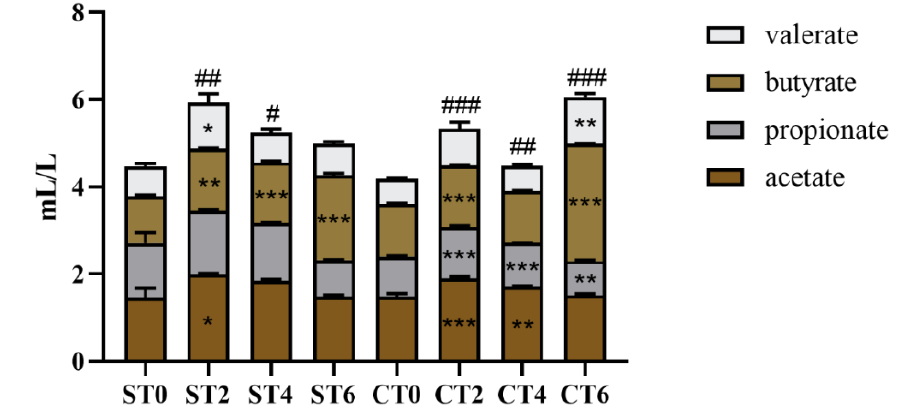
Figure 7. Content of SCFA in intestinal lumen (ST—aqueous extraction group, CT—alcohol extraction group; Comparison of SCFA between groups: * p < 0.05 ** p < 0.01 *** p < 0.001; Total acid contrast: # p < 0.05, ## p < 0.01, ### p < 0.001, compared with Day 0 for significant differences; 0—no sample added; 2, 4, 6—denote fermentation days after sample addition).